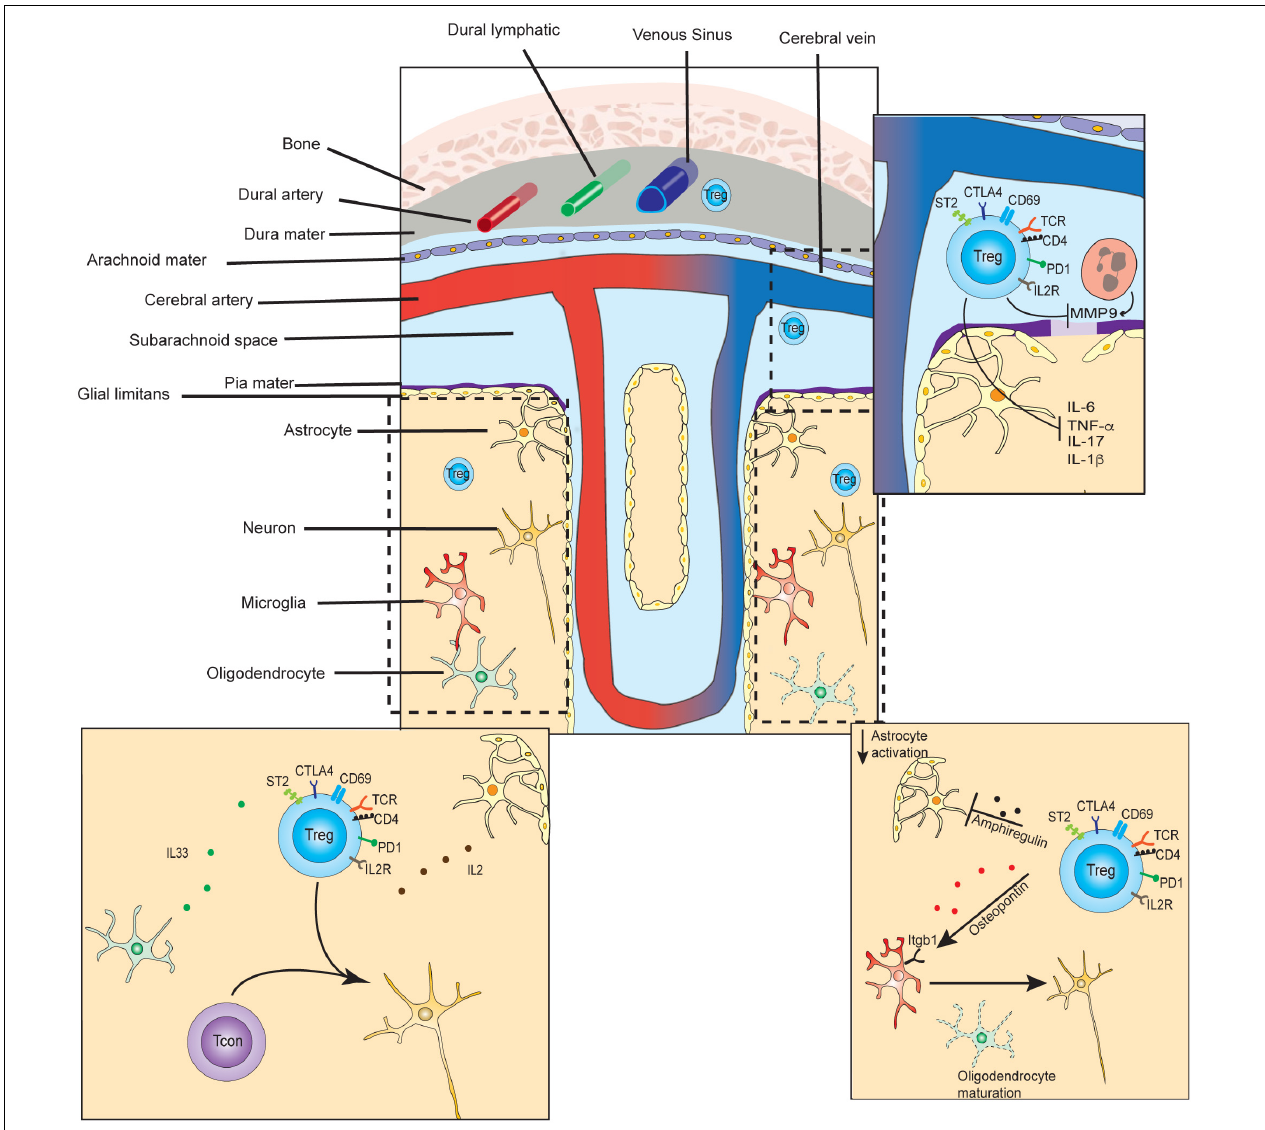
FIGURE 2 | Select functions of Tregs in CNS tissue development, homeostasis, and repair. In the steady-state, small numbers of T-regulatory cells are found transiting the dura and leptomeninges, and persisting in the brain parenchyma. CD4+ T-cells of the parenchyma contribute to microglial maturation and synaptic pruning. (Lower left inset) In the steady state, parenchymal Tregs express markers of long-term residency and are maintained by IL-2 and IL-33, which may be primarily supplied by astrocytes and oligodendrocytes, respectively. (Top right inset) In the subacute or acute period following ischemic stroke, Tregs inhibit matrix metalloproteinase 9 (MMP9) secretion from neutrophils, preventing further breakdown of the blood-brain-barrier, and diminishing inflammation. (Bottom right inset) In the chronic period of ischemic stroke recovery, CNS Tregs suppress astrogliosis via the secretion of amphiregulin, and induce oligodendrocyte maturation via secretion of